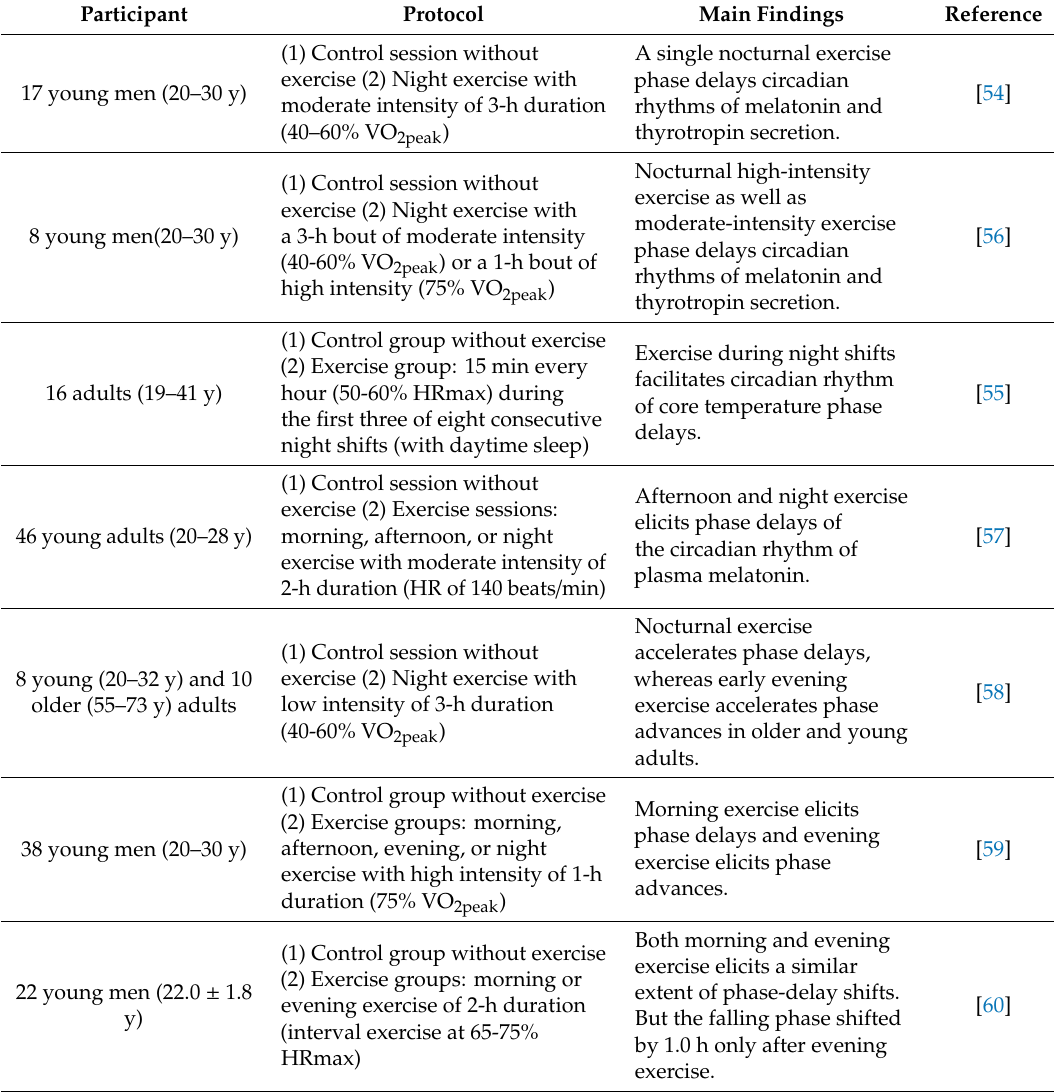
Table 2. Circadian phase-shifting e ff ects of exercise in